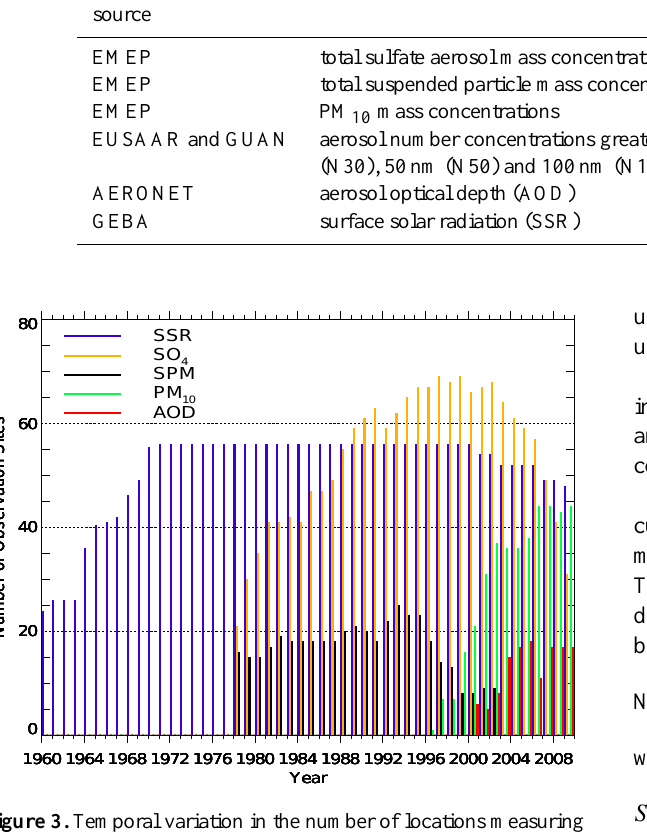
Table 1. Details of the ground-based observations used in this study. Data